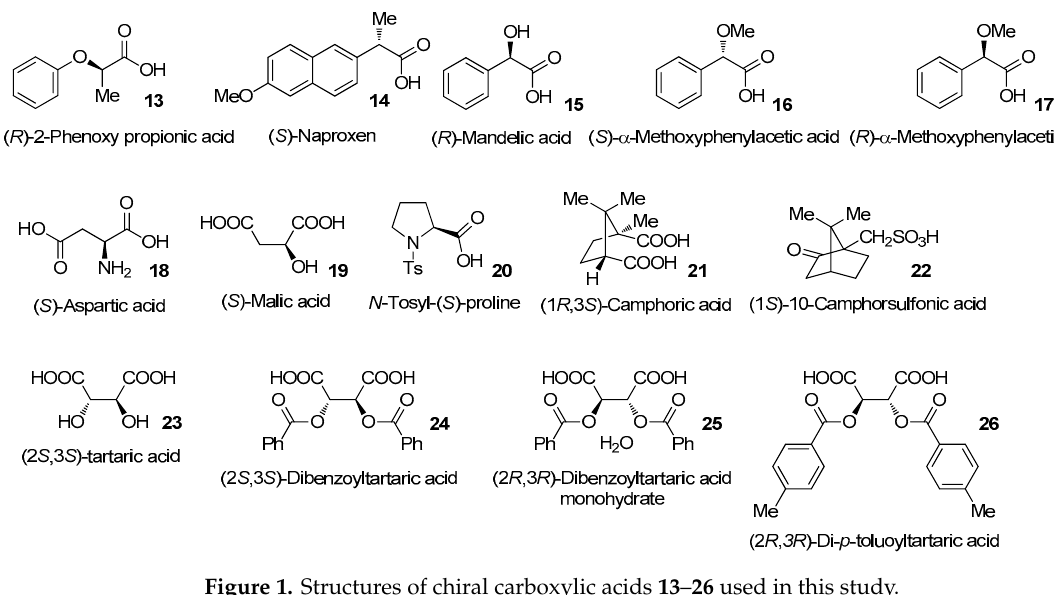
Figure 1. Structures of chiral carboxylic acids 13 – 26 used in this study. Table 1. Screening resolving reagents 13 – 26 under standard conditions.